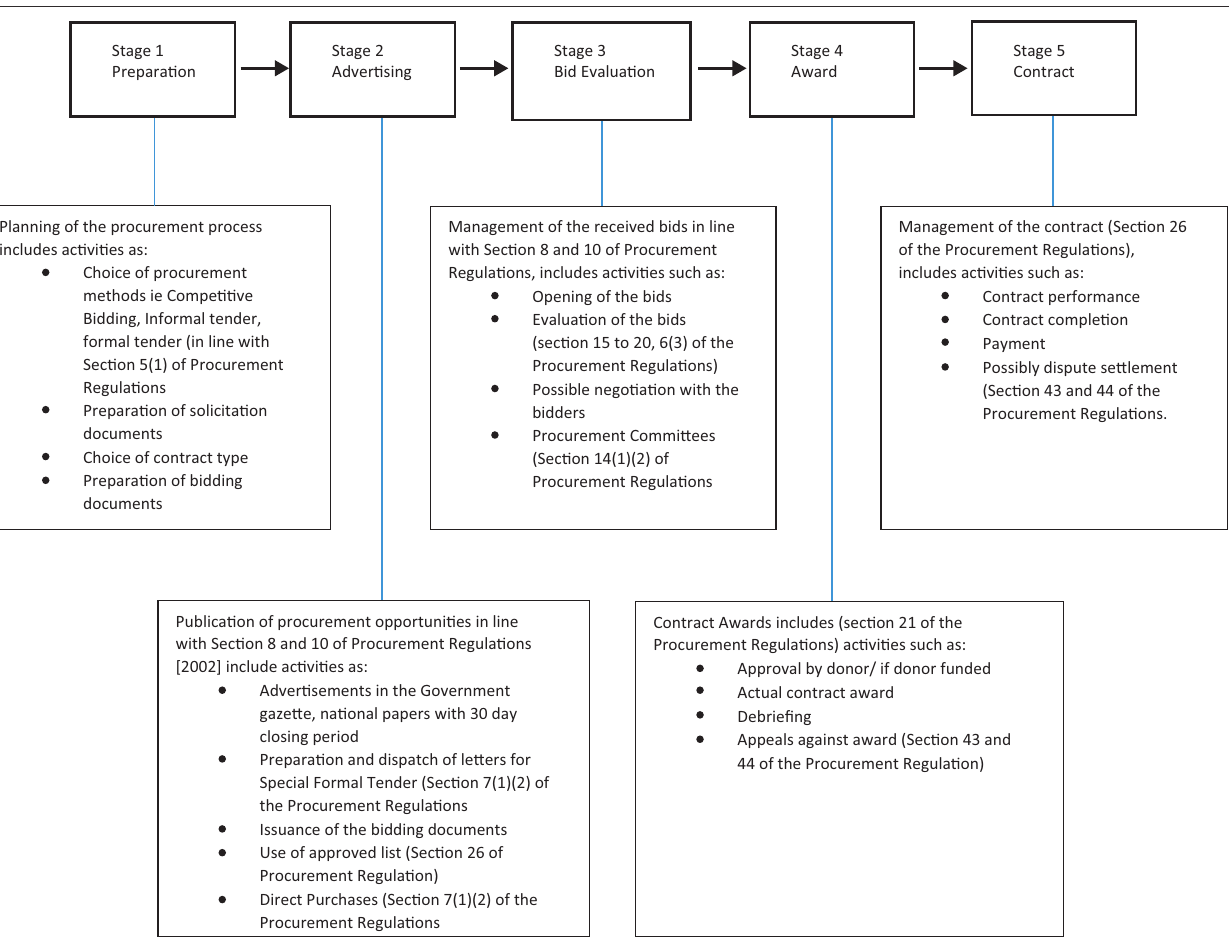
Figure 1 outlines the public procurement process adopted by Zimbabwe (Zimbabwe Government 2008).